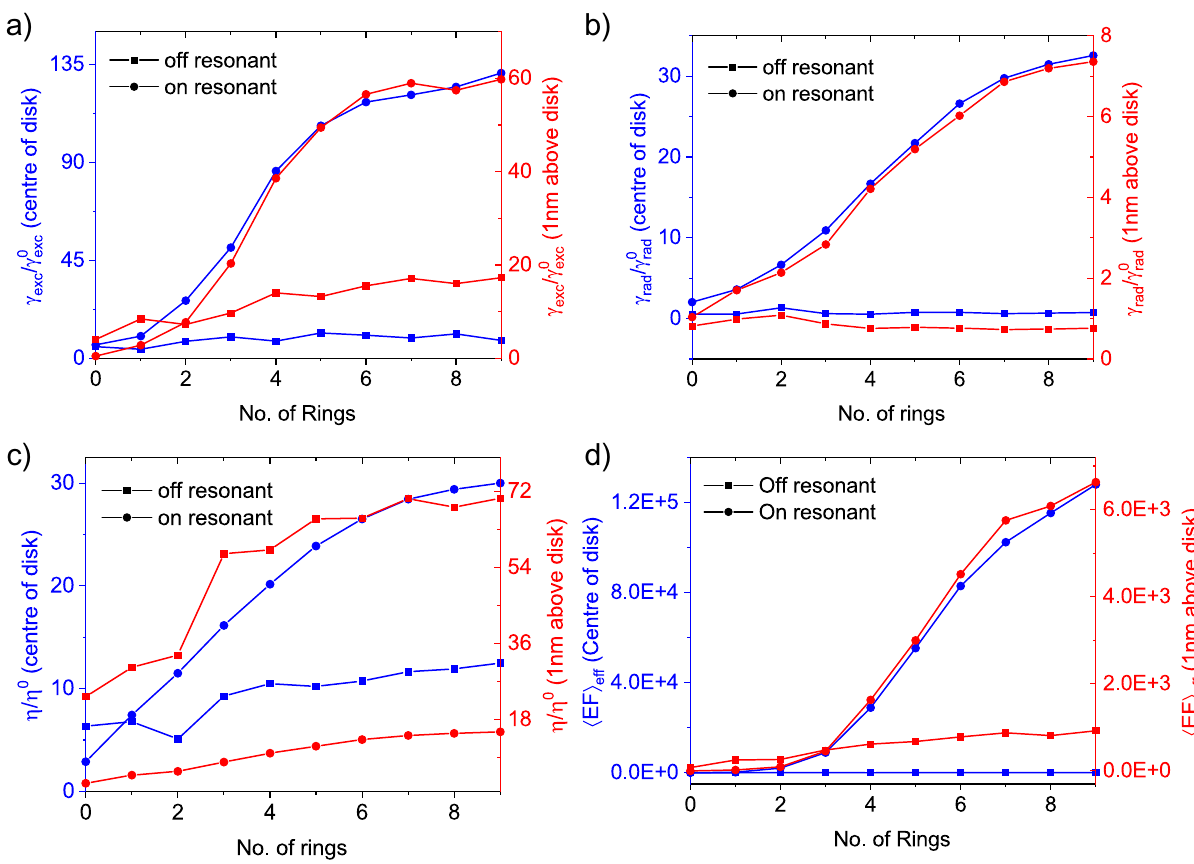
Figure 4. Dipole-cavity coupling efficiency. ( a ) Excitation enhancement rate for a dipole in the centre of the cavity (red) and a dipole 1 nm above the disk (blue) as a function of the number of rings. Square and circular shapes illustrate off-resonance (532 nm) and on-resonance (752.5 nm) excitation, respectively, exciting the structure with a plane wave and monitoring the field intensity. ( b ) The radiative decay rate enhancement as a function of the number of rings. ( c ) The collection efficiency enhancement as a function of the number of rings. In all plots, one can observe the general trend of increasing performance of the cavity with more rings. ( d ) Effective enhancement for a dipole positioned at the centre of disk (blue) and a dipole positioned 1 nm above the disk (red). In the simulations on a device with zero rings it still contains a central disc of dielectric with = 1.67 µ m which may enhance the figures of R TiO 2